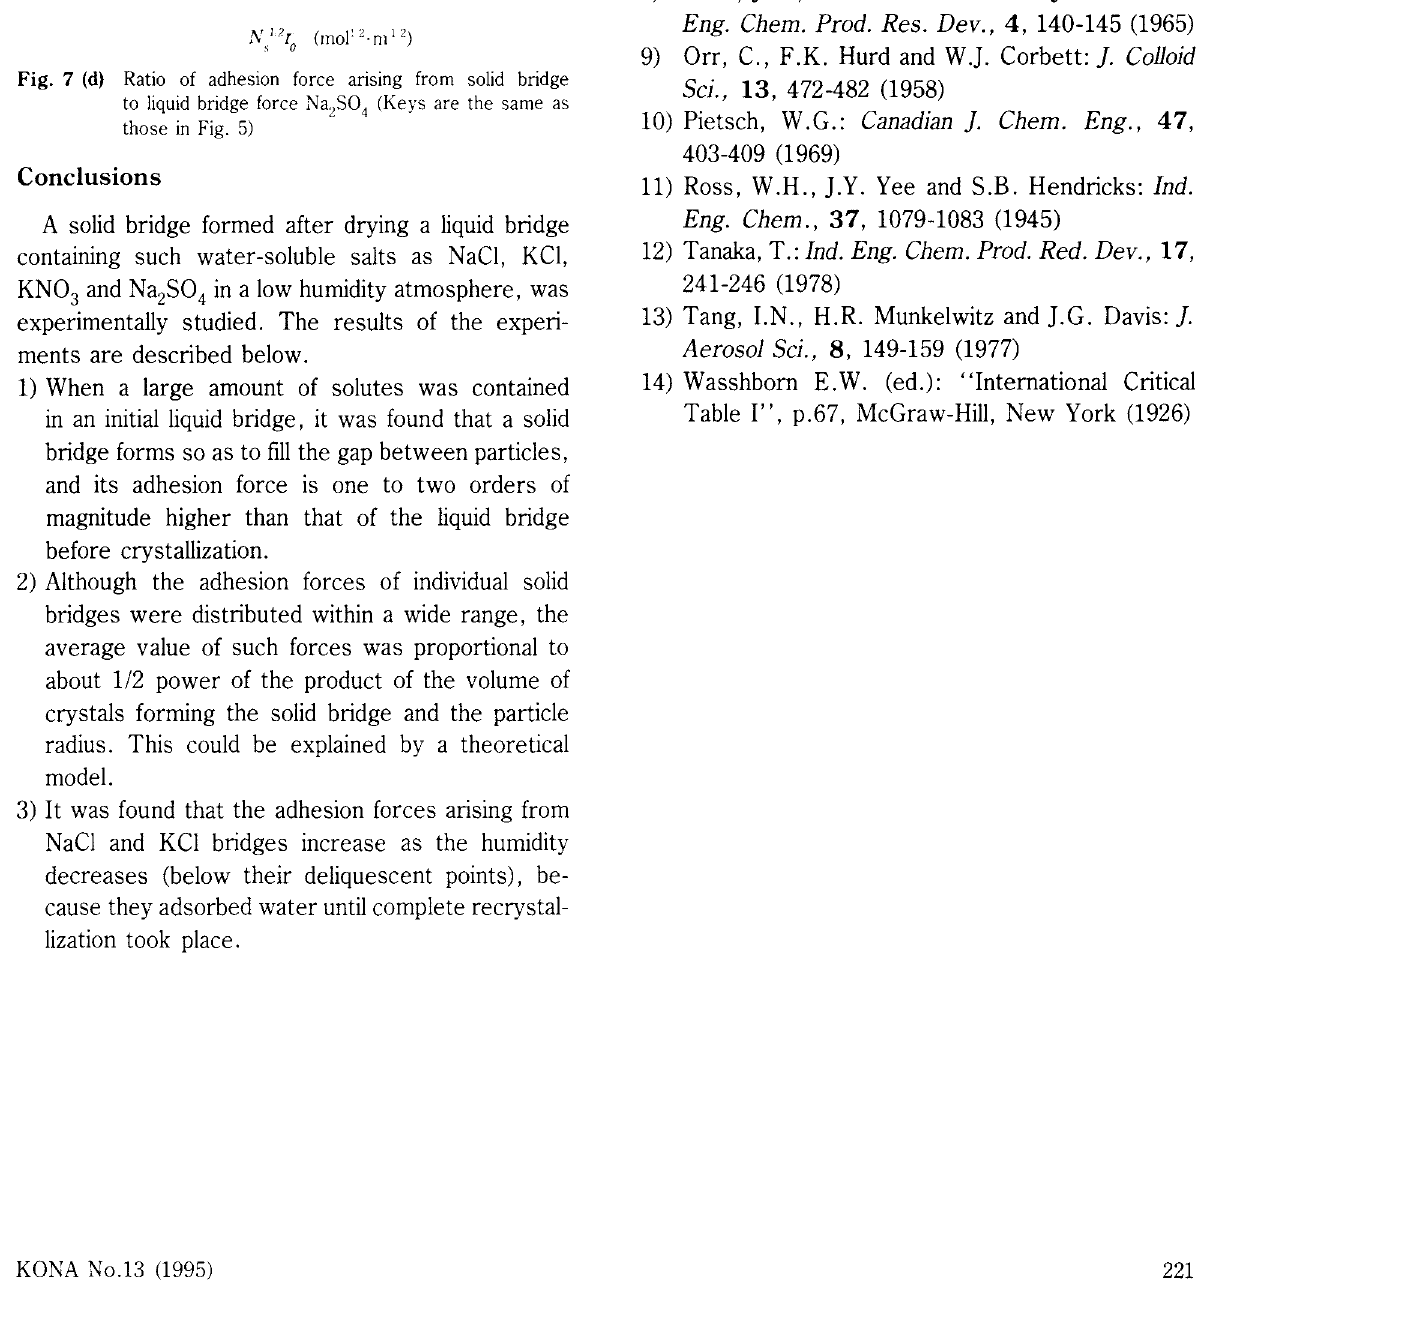
Fig. 7 (d) Ratio of adhesion force arising from solid bridge to liquid bridge force Na those in Fig. 5)